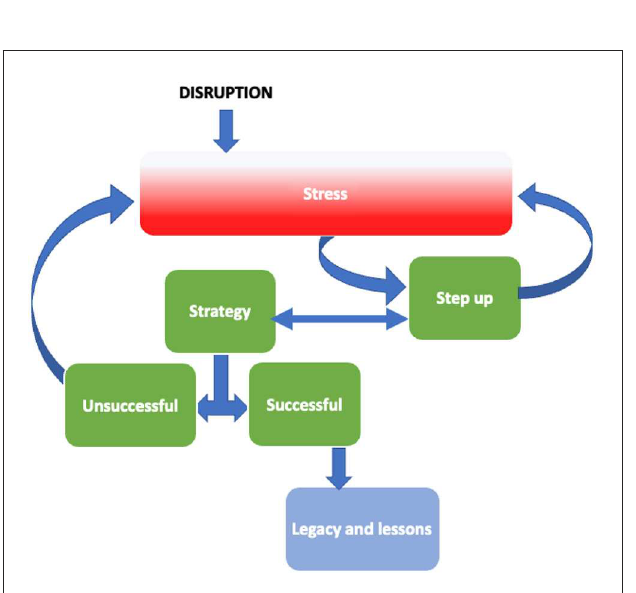
FIGURE1 Major themes from narratives.